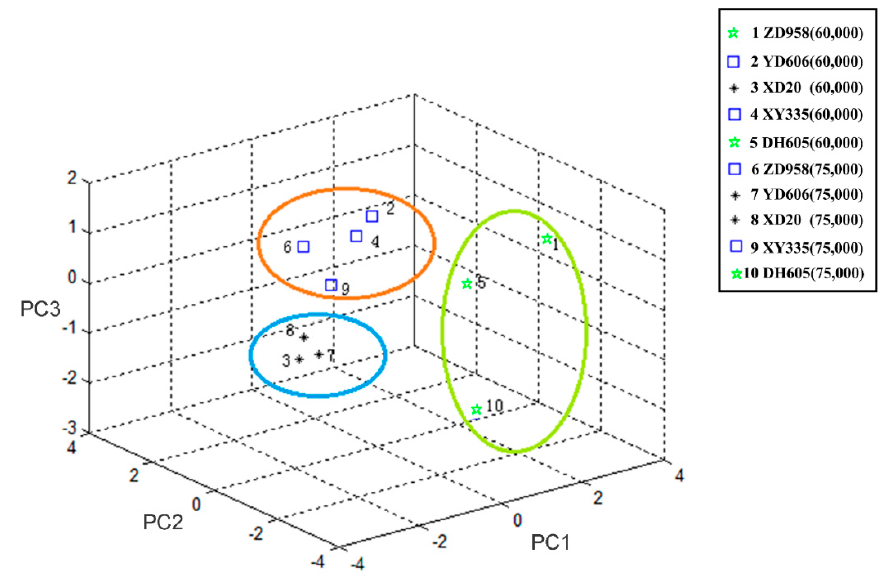
Figure 3. The scatter plot of the component scores obtained from five corn varieties with two planting densities. Table 2. The lodging rates recorded from the experimental samples in 2016 and 2017.